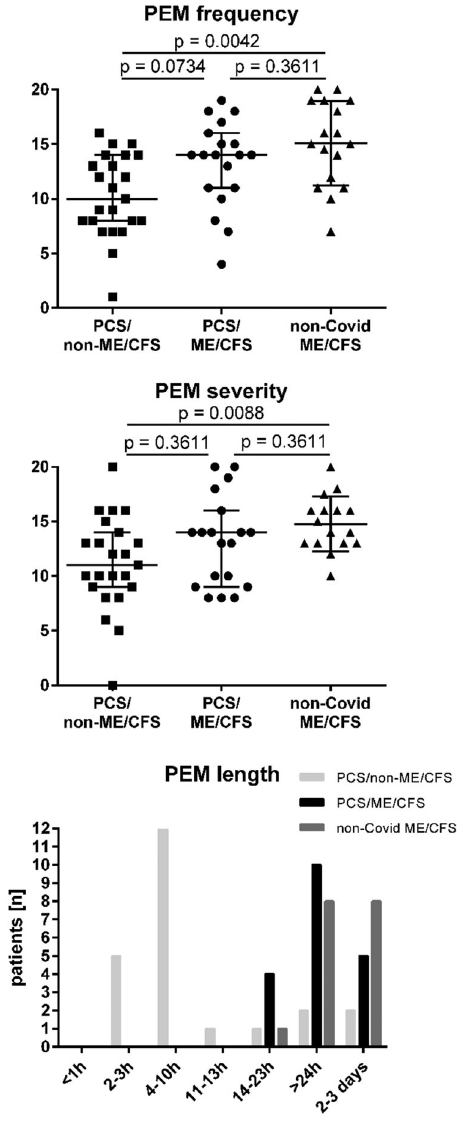
Fig. 2 | Frequency, severity, and length of post-exertional malaise (PEM). PCS/non-ME/CFS post-COVID-19 syndrome/non-myalgic encephalomyelitis/ chronic fatigue syndrome; PCS/ME/CFS post-COVID-19 syndrome/myalgic ence- phalomyelitis/chronic fatigue syndrome; non-COVID ME/CFS non-COVID-19 myal- gic encephalomyelitis/chronic fatigue syndrome; PEM post-exertional malaise. Frequencyandseverity of PEMwas assessedona fi veitems scale with 0 – 20 points ( “ none ” to “ all of the time ” / “ very severe ” ) and the length in seven categories (from <1h to 2 – 3 days), according to Cotler 10 . Median and IQR (interquartile range) in PCS/ME/CFS ( n =19), PCS/non-ME/CFS ( n =23), and non-COVID ME/CFS patients ( n =17 for frequency and length, and n =16 for severity) is shown. Data were ana- lyzed with nonparametric all-pairs Dunn-type multiple contrast tests. The p values were adjusted for multiplicity across endpoints with the Benjamini-Hochberg (BH) correction. Source data are provided as a Source Data fi